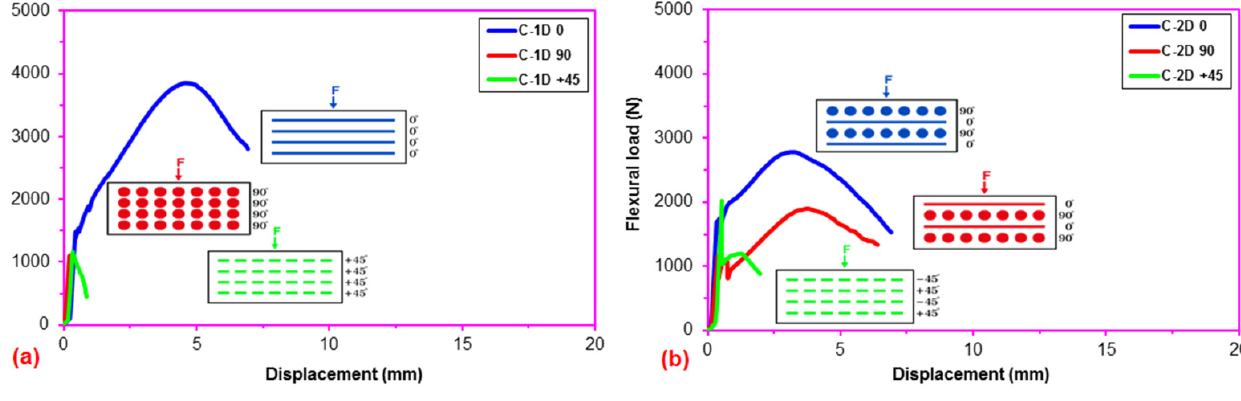
Figure 9. General characterization of off-axis flexural load-displacement curves of the multiaxis 3D carbon fiber concretes. ( a ) C-1D concrete and ( b ) C-2D concrete composite.